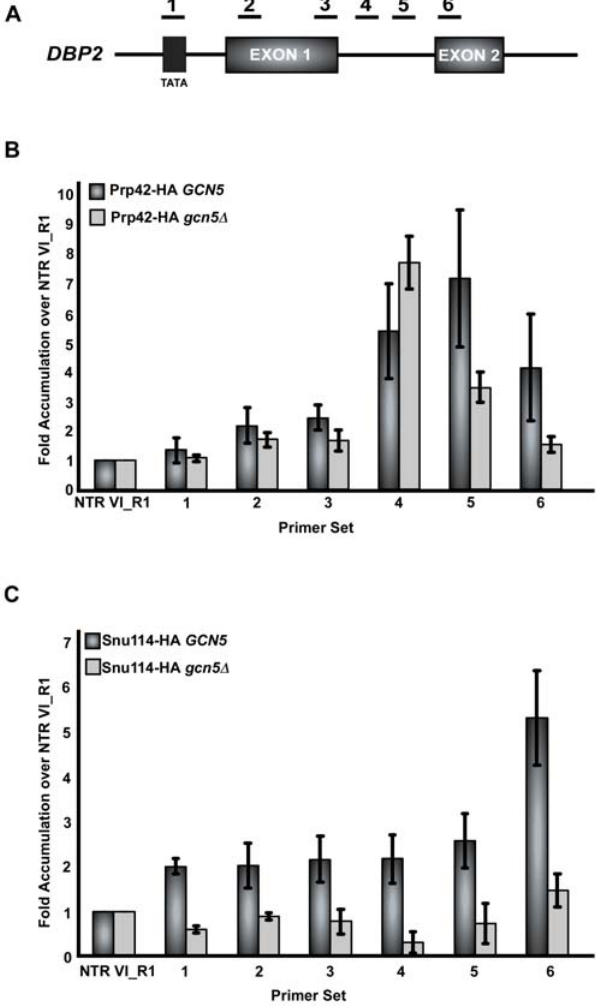
Figure 5. Co-transcriptional recruitment of U1 snRNP and U5 snRNP in the presence and absence of GCN5 . (A) Schematic of the intron-containing gene, DBP2 . Underlined numbers represent the amplicons generated from each primer set used in the study. (B) Bar graph depicting recruitment of U1 snRNP (Prp42-HA) in the presence and absence of GCN5 . Dark grey bars represent the occupancy of Prp42- HA in the presence of wild-type GCN5 and light grey bars represent Prp42-HA in the absence of GCN5 . Occupancy is measured as fold accumulation over the non-transcribed region. (C) Bar graph depicting the recruitment of U5 snRNP (Snu114-HA) in the presence and absence of GCN5 . Dark grey bars represent the Snu114-HA in the presence of GCN5 , and light grey bars represent Snu114-HA occupancy in the absence of GCN5 . Graphs represent the average of at least three independent experiments, and error bars represent the standard deviation.